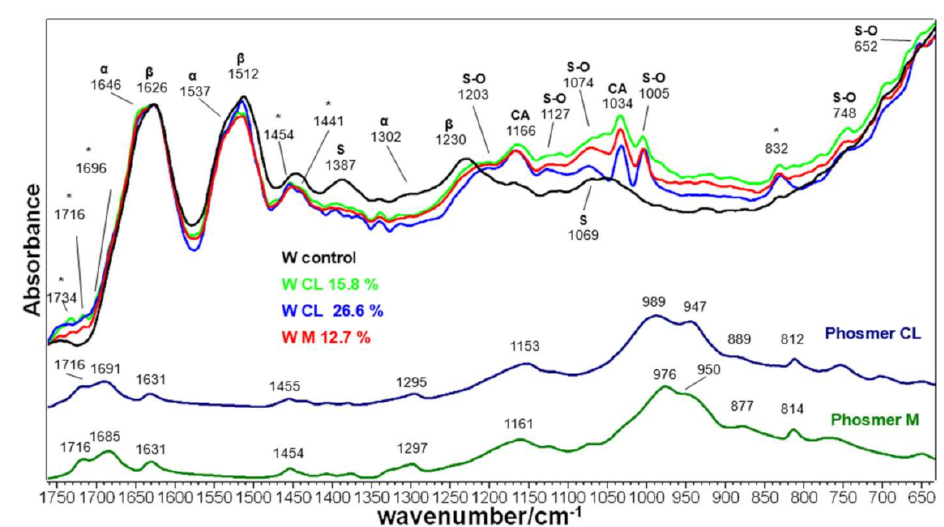
Figure 14. IR spectra of wool keratin fabrics before (control) and after grafting with phosmer CL (weight gains 15.8% and 26.6%) and M (weight gain 12.7%). The spectra are normalized to the Amide I band. The spectra of phosmers CL and M are reported for comparison; the main bands that in the grafted samples strengthened due to their contribution are indicated with * (see Supplementary Material for assignments). The main bands attributed to β -sheet ( β ) and α -helix ( α ) conformations, as well as to serine (S), cysteic acid (CA), and other sulfur oxidation products (S-O), are